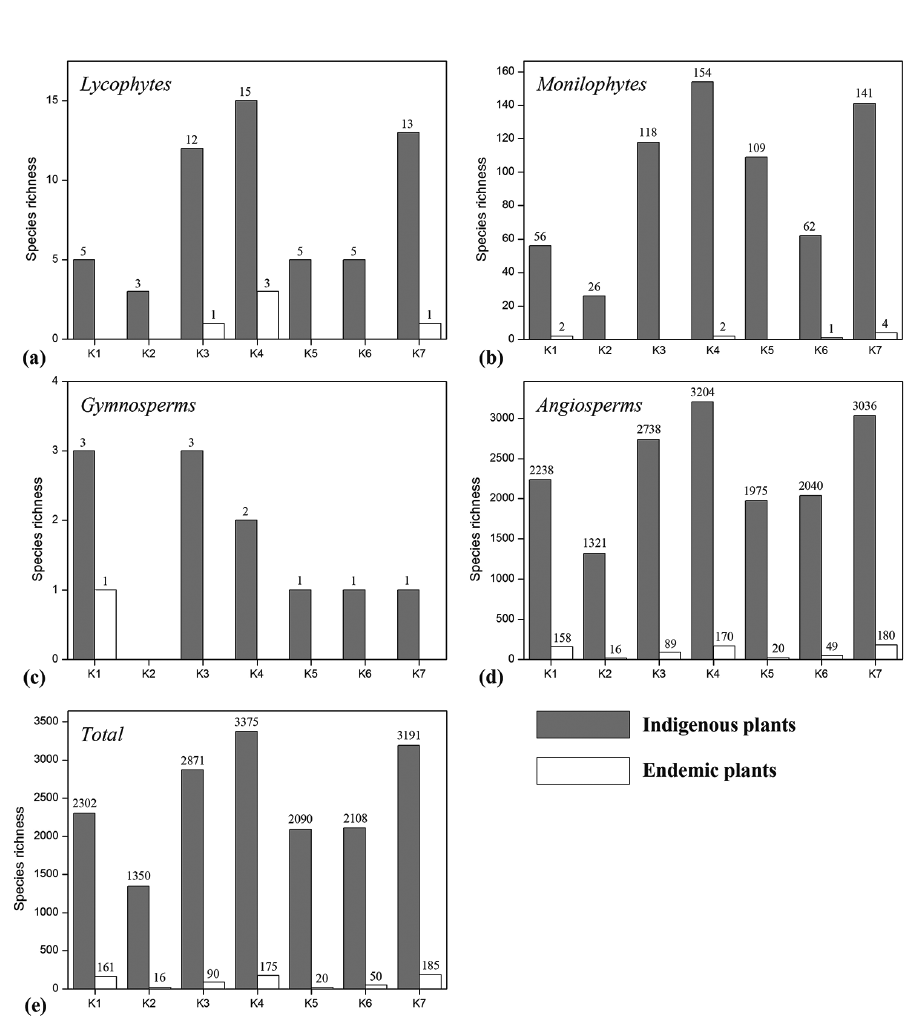
Figure 2. Lycophytes ( a ), monilophytes ( b ), gymnosperms ( c ), angiosperms ( d ) and total ( e ) species richness of indigenous (grey bars) and endemic (white bars) vascular plants in K1–K7 regions of